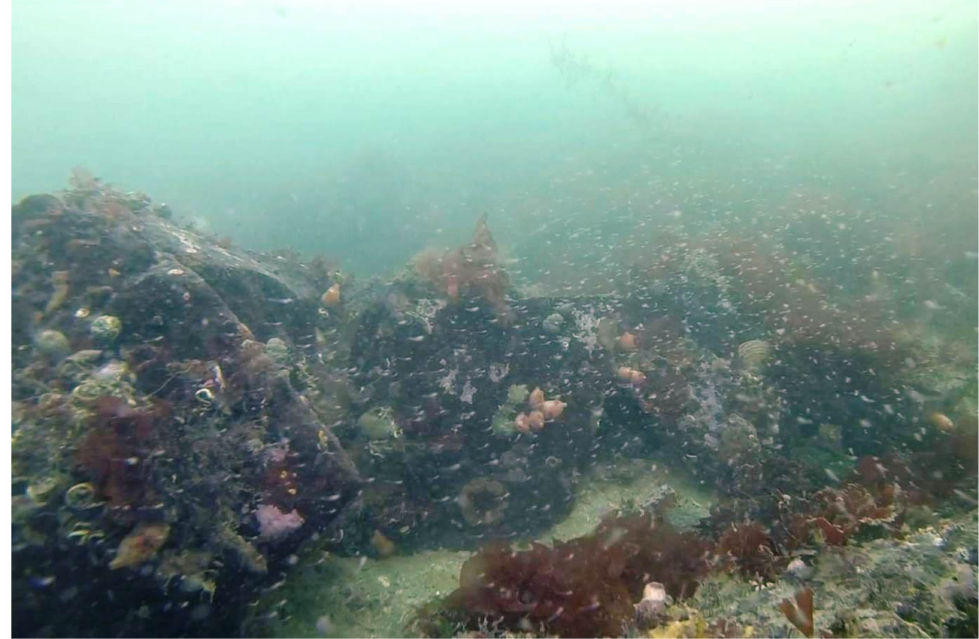
Figure 7. Photograph of the spawning ground of the Pacific herring ( Clupea pallasii ) during a scuba survey on the Nanpo-ri Coast in Jinhae Bay in February